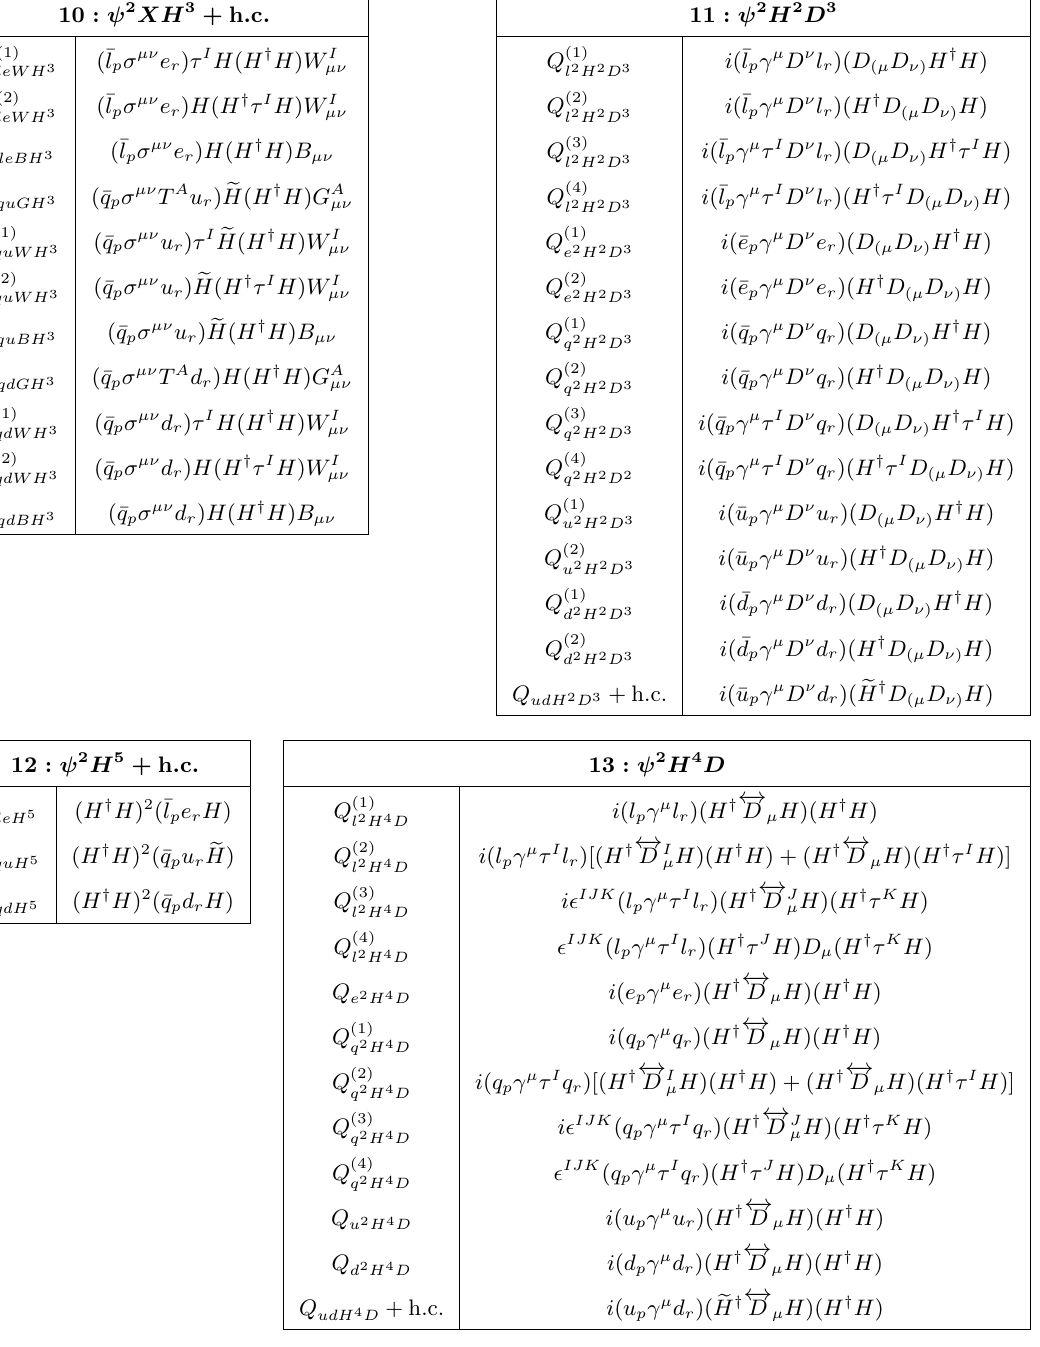
Table 5 . The dimension-eight operators in the SMEFT of classes-10, through -13, all of which have two fermions. The operators Q and Q have Hermitian conjugates. The subscripts p; r udH 4 D udH 2 D 3 are weak-eigenstate